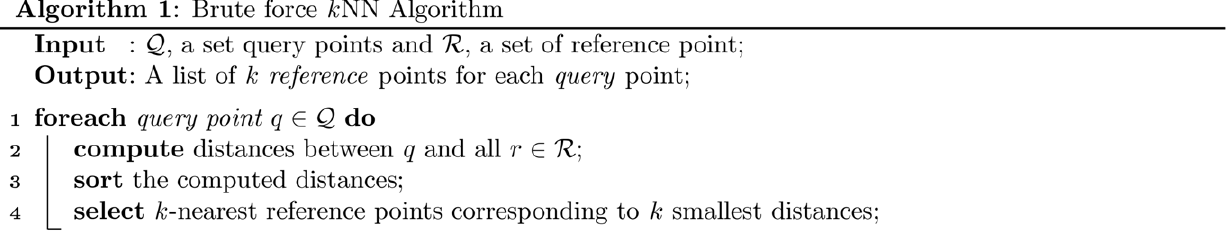
Figure 1. Pseudo-code for the Brute Force k NN Algorithm. The run time complexity of the algorithm is O ( mnd ) z O ( mn log n ), considering a total of n query points and m reference points in a d -dimensional space.